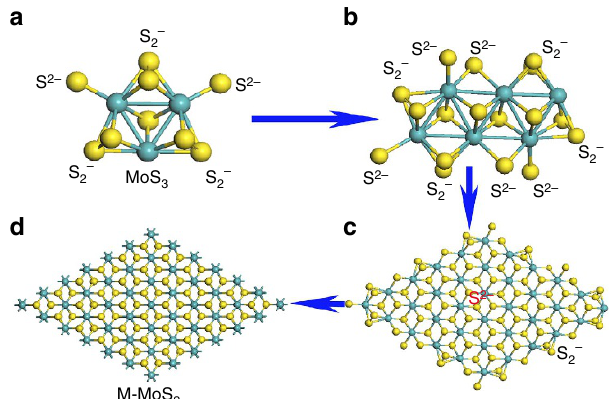
Figure 5 | Schematic illustrations of the evolution process of M-MoS 2 from MoS 3 . ( a ) One MoS 3 cluster with S 2 (cid:2) and S 2 (cid:2) . ( b ) Combination of two MoS 3 clusters with the breaking of S 2 (cid:2) . ( c ) Several MoS 3 cluster forming MoS 2 with S 2 (cid:2) in the centre and MoS 3 with S 2 (cid:2) at the edge. ( d ) Stable M-MoS 2